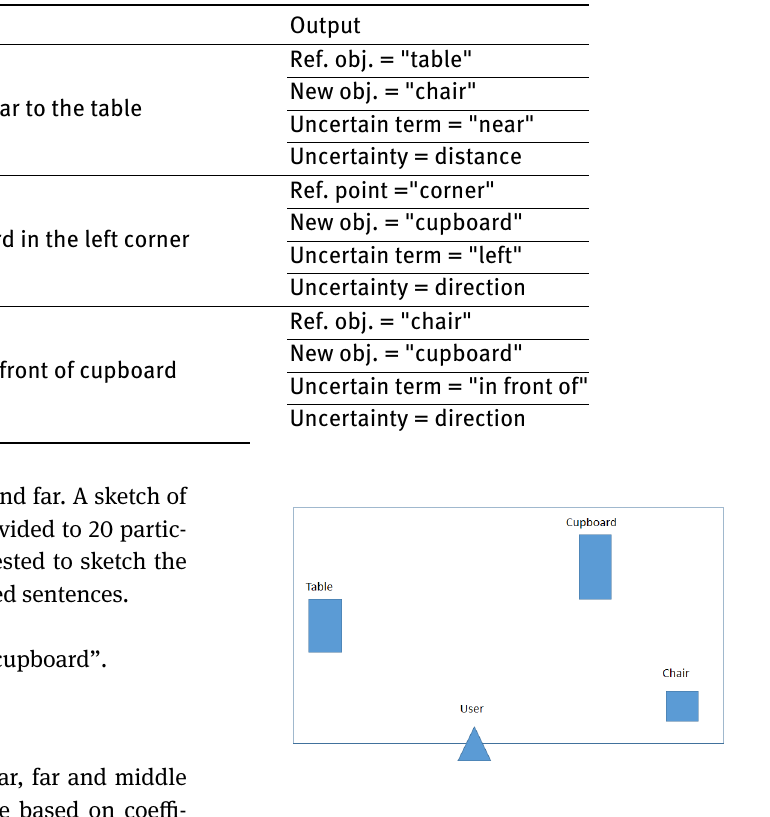
Figure 3: The map of the environment designed for human study explained in Section 3.1.